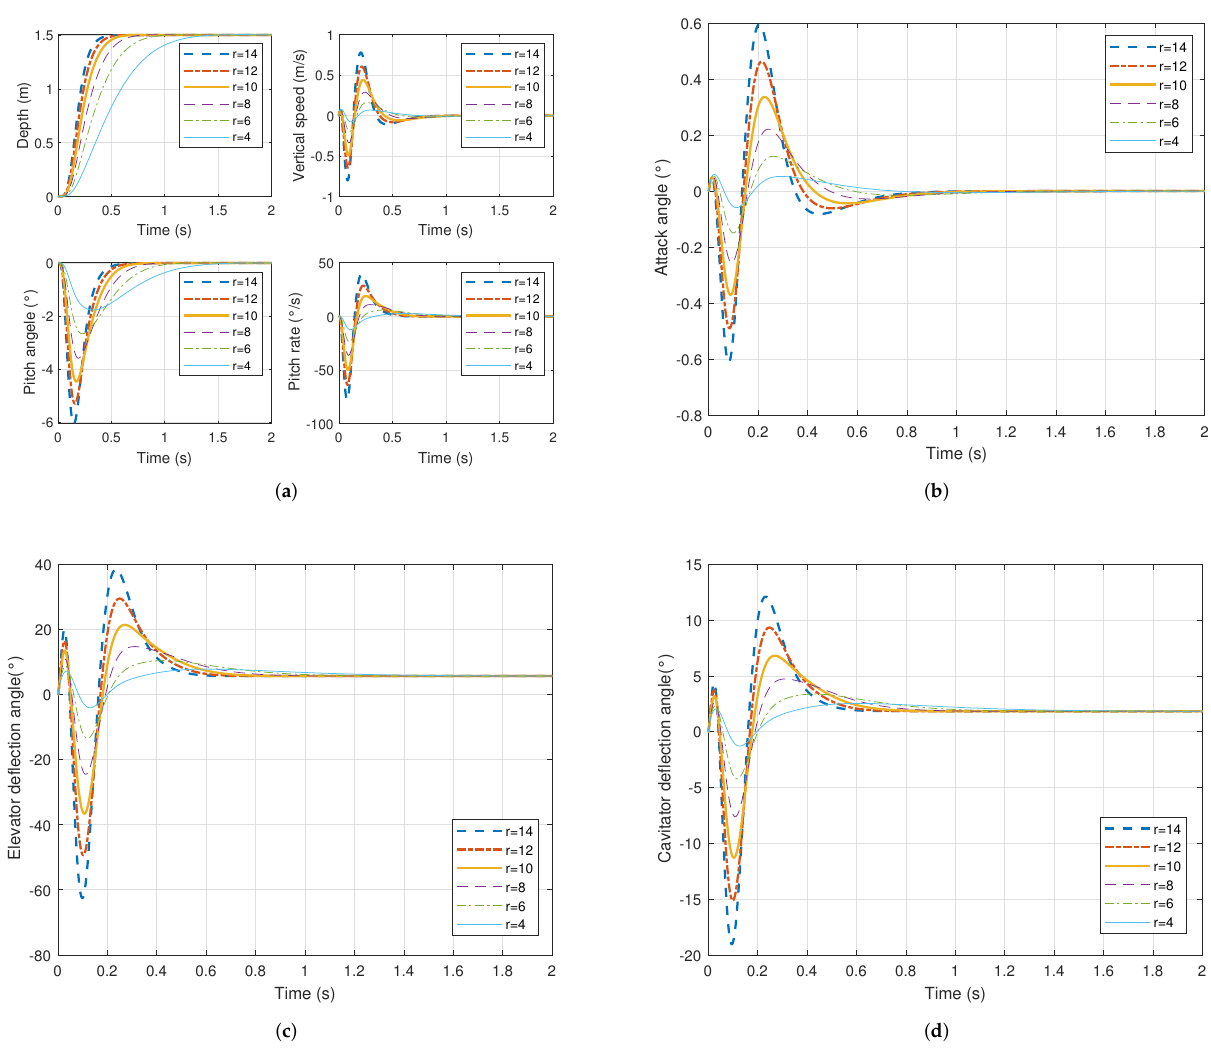
Figure 10. States, attack angle and actuator deflections comparison of the supercavitating vehicle with different TD parameters: ( a ) Four states comparison; ( b ) Attack angle comparison; ( c ) Elevator deflection angle comparison; ( d ) Cavitator deflection angle